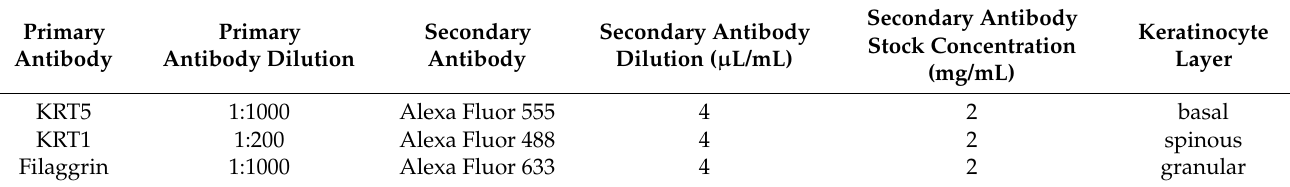
Table 2. List of antibodies and dilution concentrations used in the cell viability